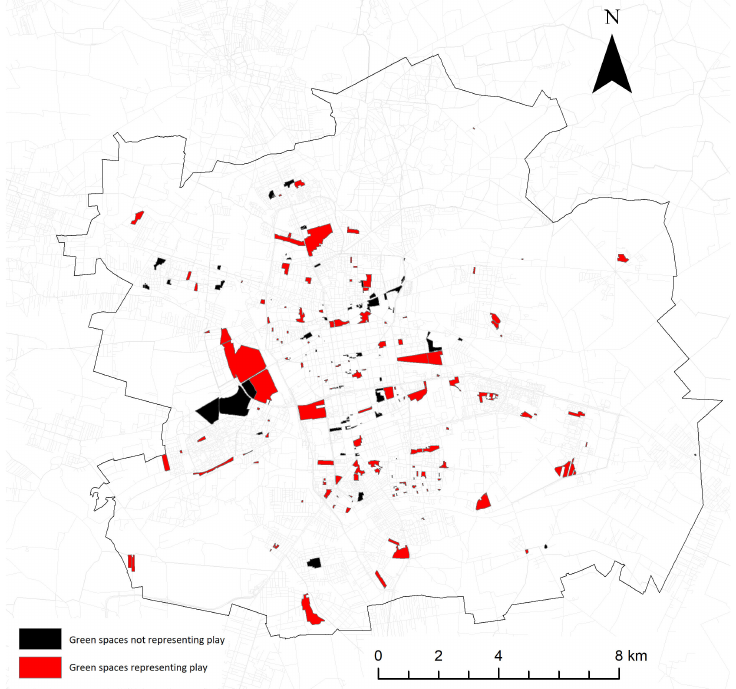
Figure 3. Urban green spaces in Lodz representing the “play” sociotope